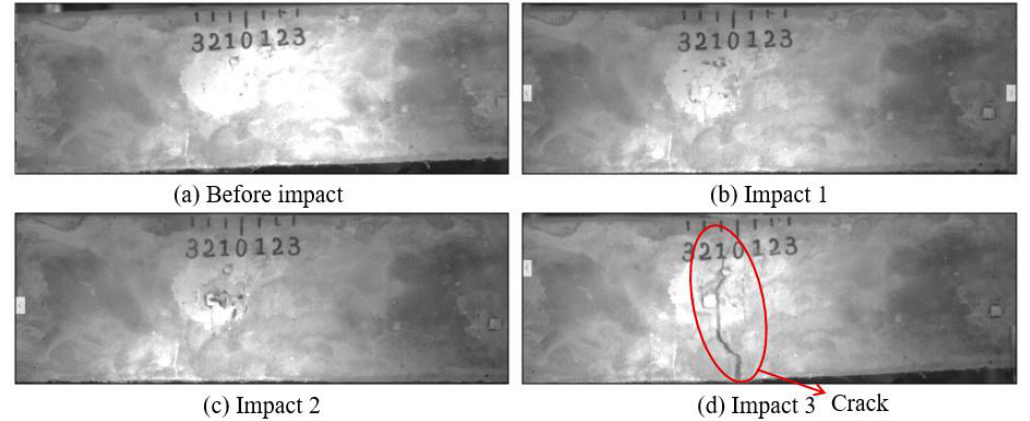
Figure 16 . Results of crack detection in PVA-ECC-3 with high-speed video.